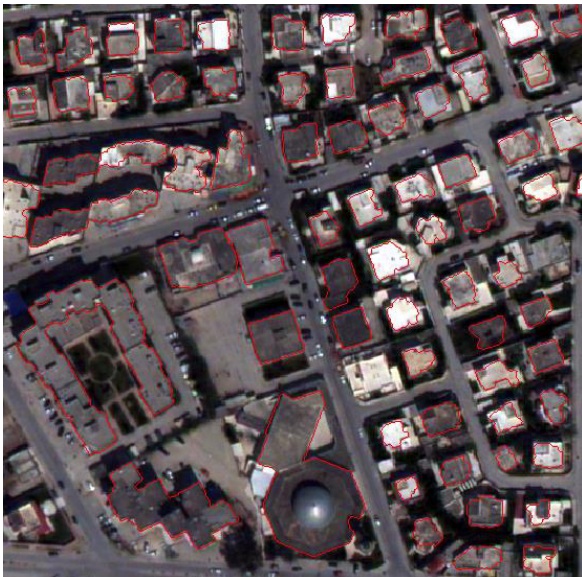
Figure 6. Results of EG_AC upon RGB image in level 3 of building extraction. Red boundaries are the output of level